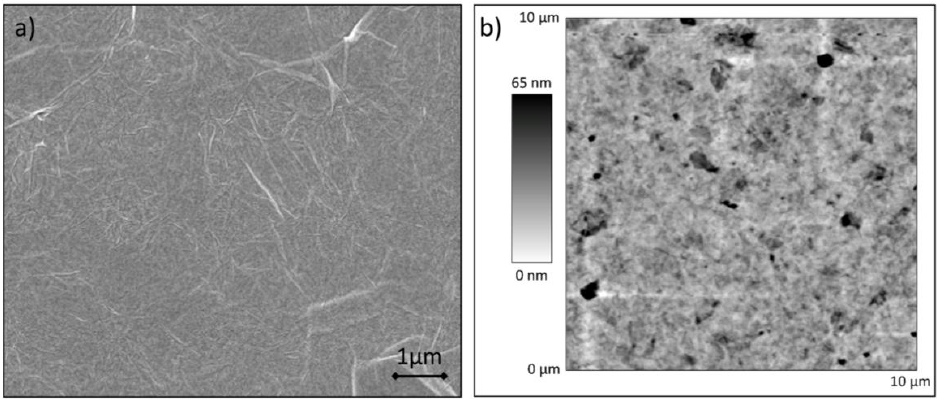
Figure 3. Images of the superficial structure of a 1-bilayer PEI/GO coating deposited onto glass slide: ( a ) SEM and ( b ) AFM.